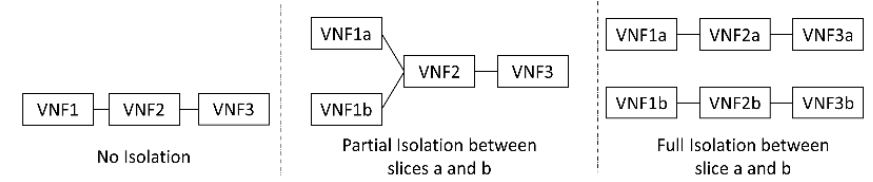
Figure 1. Isolation in network slice provisioning.